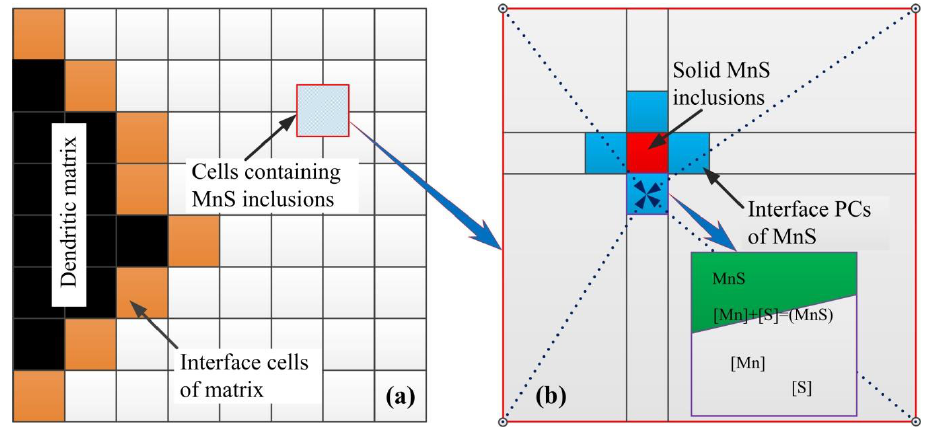
Figure 2. Grid meshing illustration for CA (cellular automaton) model: ( a ) meshed grids for matrix growth and ( b ) re-meshed PCs (precipitation cells) for MnS precipitation. growth and ( b ) re-meshed PCs (precipitation cells) for MnS